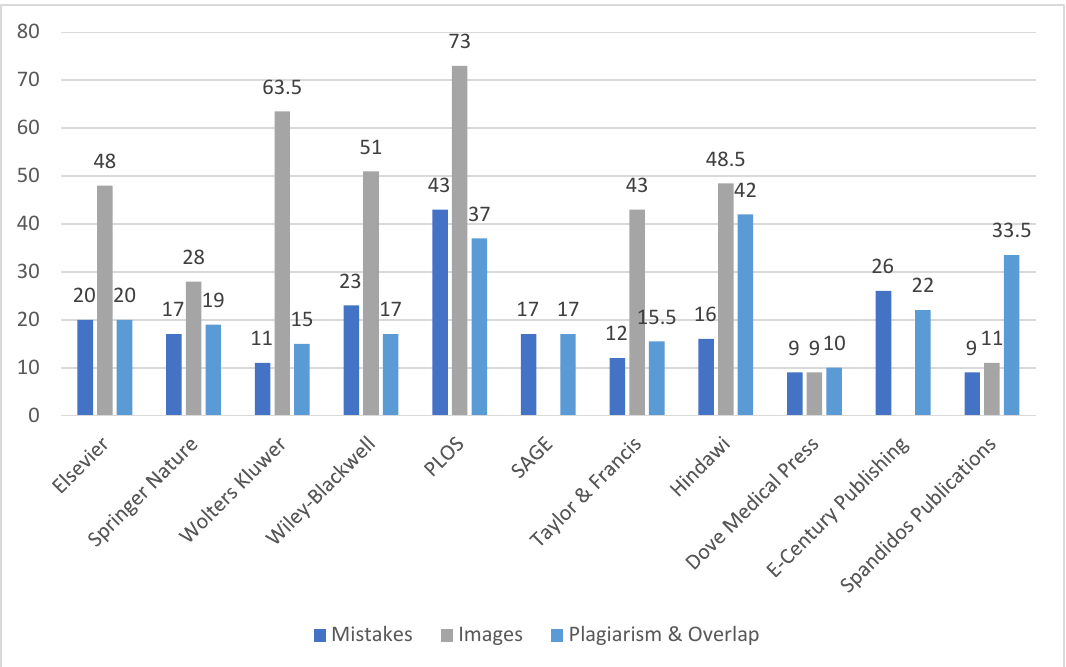
Figure 1. Median values (in months) of the top three retraction reasons for the top 11 publishers.